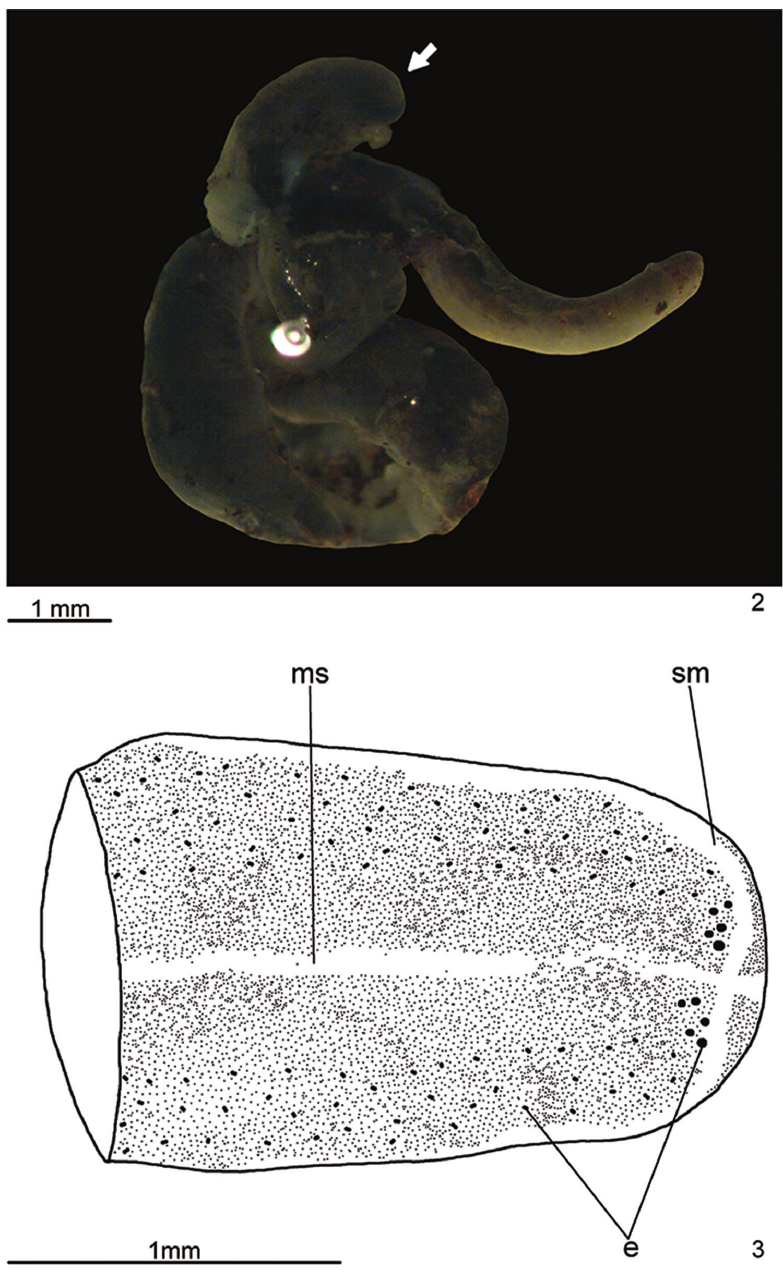
Figures 2–3. Pasipha ferrariaphila sp. n., holotype, dorsal view, 2 general view of preserved specimen 3 schematic drawing of the anterior region of body. The arrow indicates the anterior extremity. Eyes were drawn based on observations carried out under both stereomicroscope and